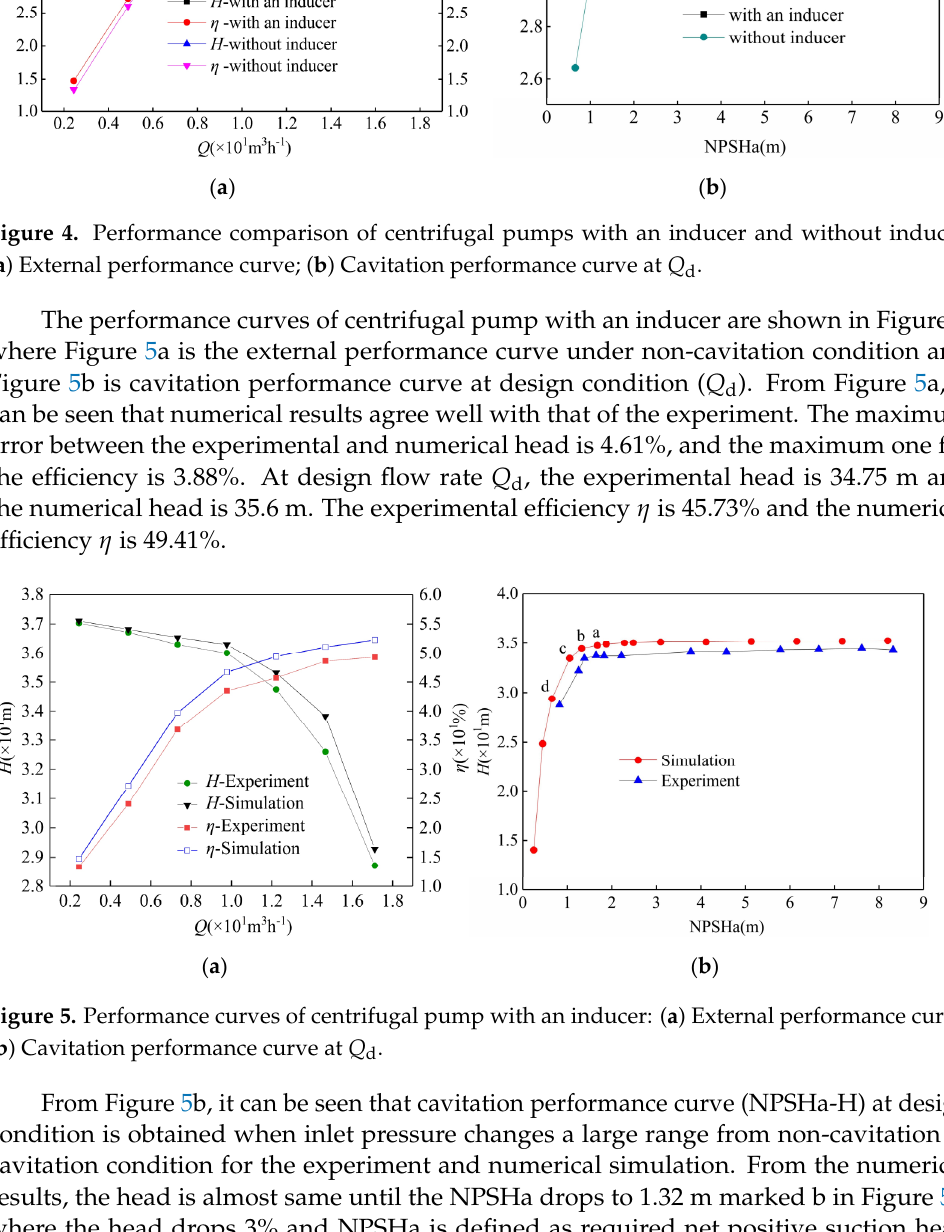
( d ) Figure 6. Static pressure distributions in the inducer: ( a ) NPSHa = 1.67 m; ( b ) NPSHa = 1.32 m; ( c ) NPSHa = 1.05 m; ( d ) NPSHa = 0.65 m.